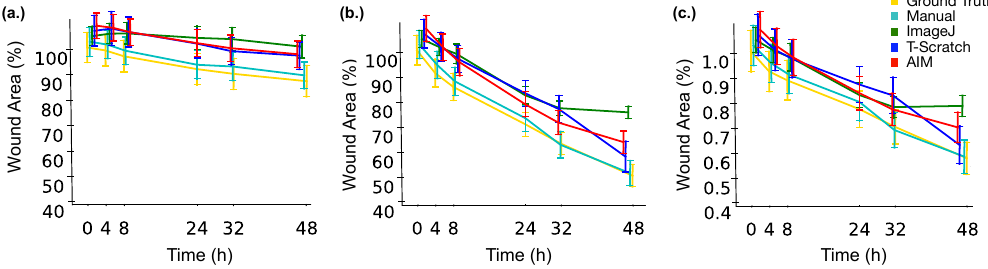
Figure 2. Time course of the percentage of wound area over time. In ( a ), the control condition is reported; while ( b ) shows the data relative to the transforming growth factor β 1 (TGF- β 1) treated cells; finally in ( c ), the ratio between the treatment and control condition is